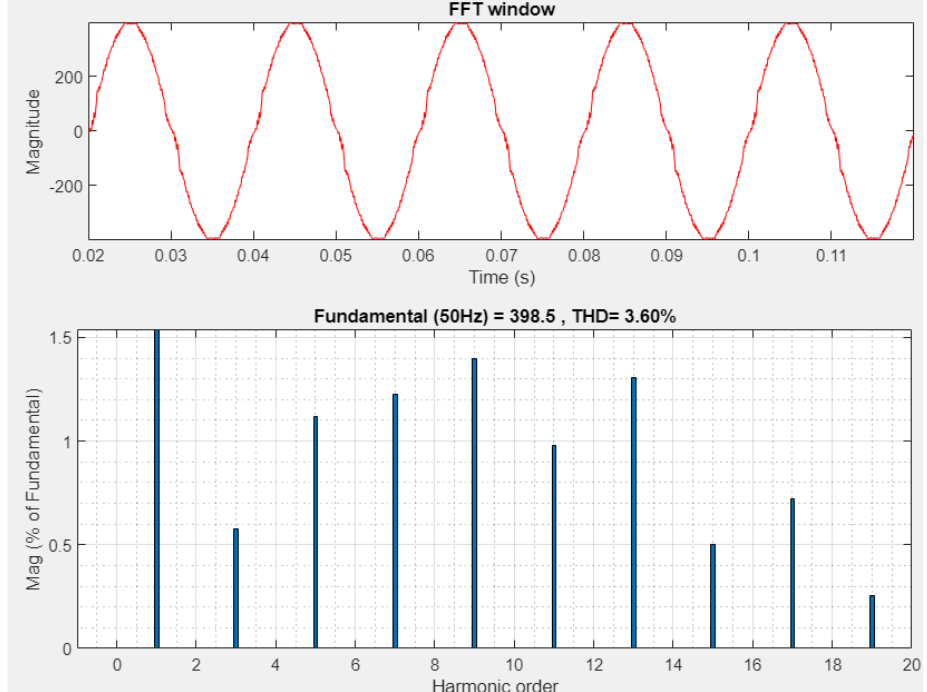
Figure 29. FFT spectrum of the output voltage after filtering.